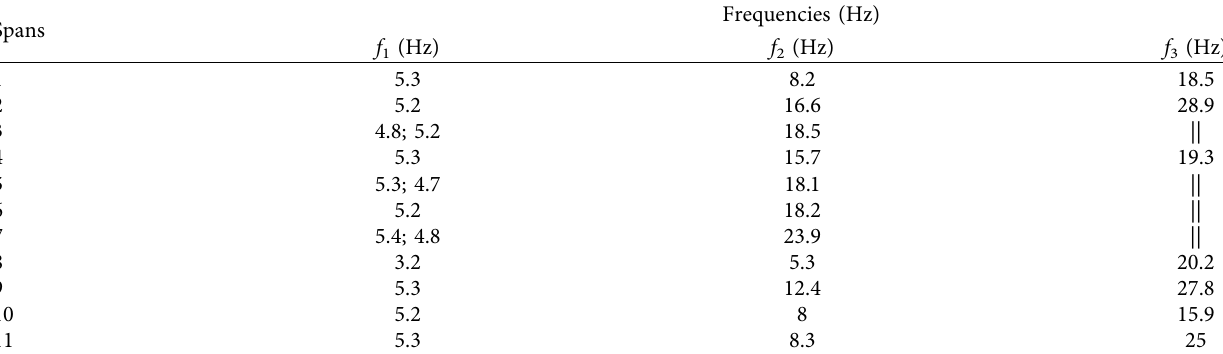
Table 13: Vibration frequencies corresponding to different axes of some contiguous spans and piers of Giong Ong To 2 bridge. Spans